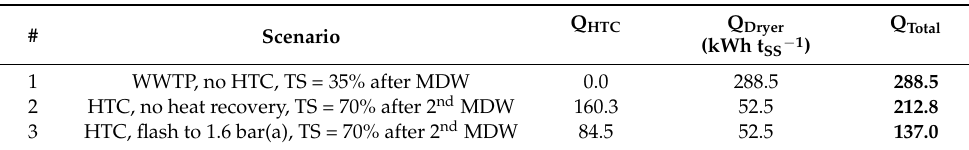
Table 7. Comparison of three scenarios and their thermal energy needed to supply a solid product with a total solids content of 90%.